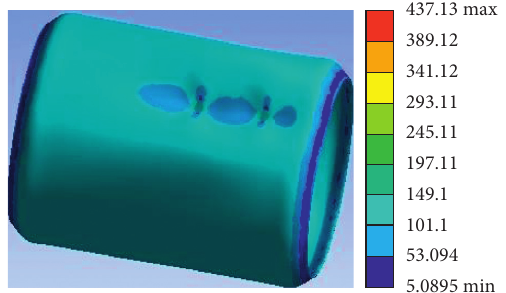
Figure 8: Equivalent stress cloud diagram of the drum.